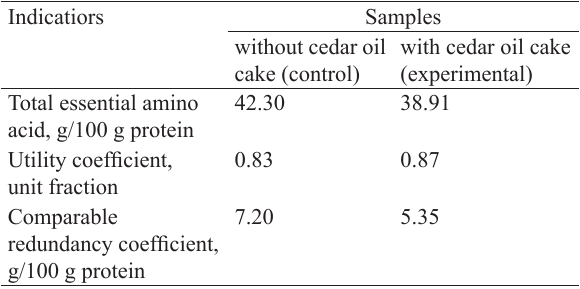
Table 4 Biological value of protein in semi-smoked sausages Indicatiors Samples without cedar oil with cedar oil cake cake (control) (experimental) Total essential